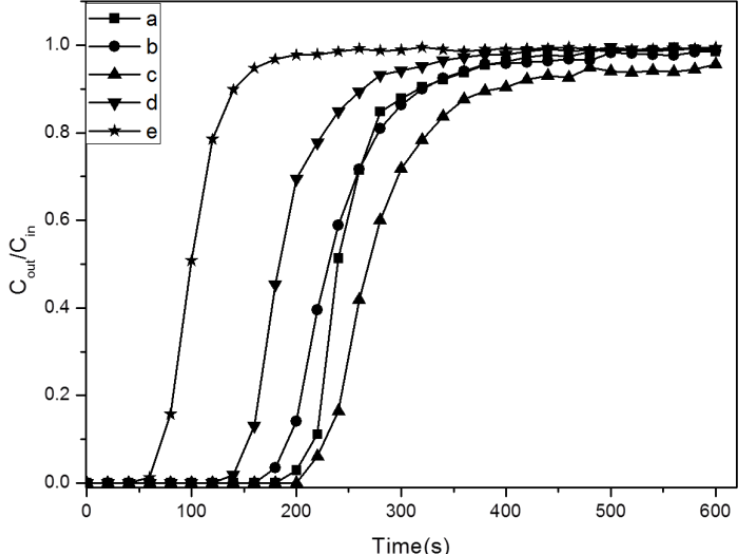
adsorption at 25 °C. a: APTMS-SBA-15-ex; Figure 8. Breakthrough curves of CO 2 b: AEAPS-SBA-15-ex; c: TA-SBA-15-ex; d: APTMS-SBA-15-c; e: